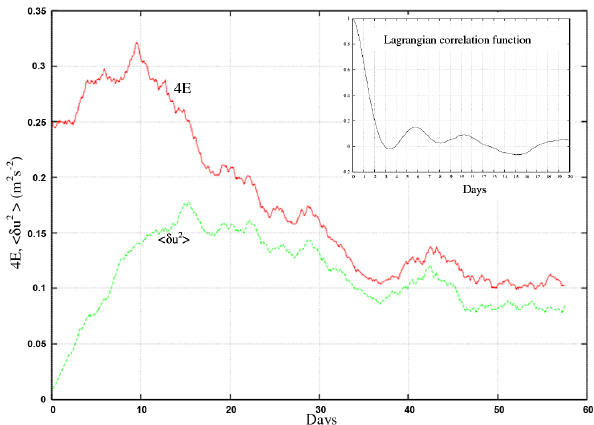
(red curve) for D 0 = 16 . 65km.